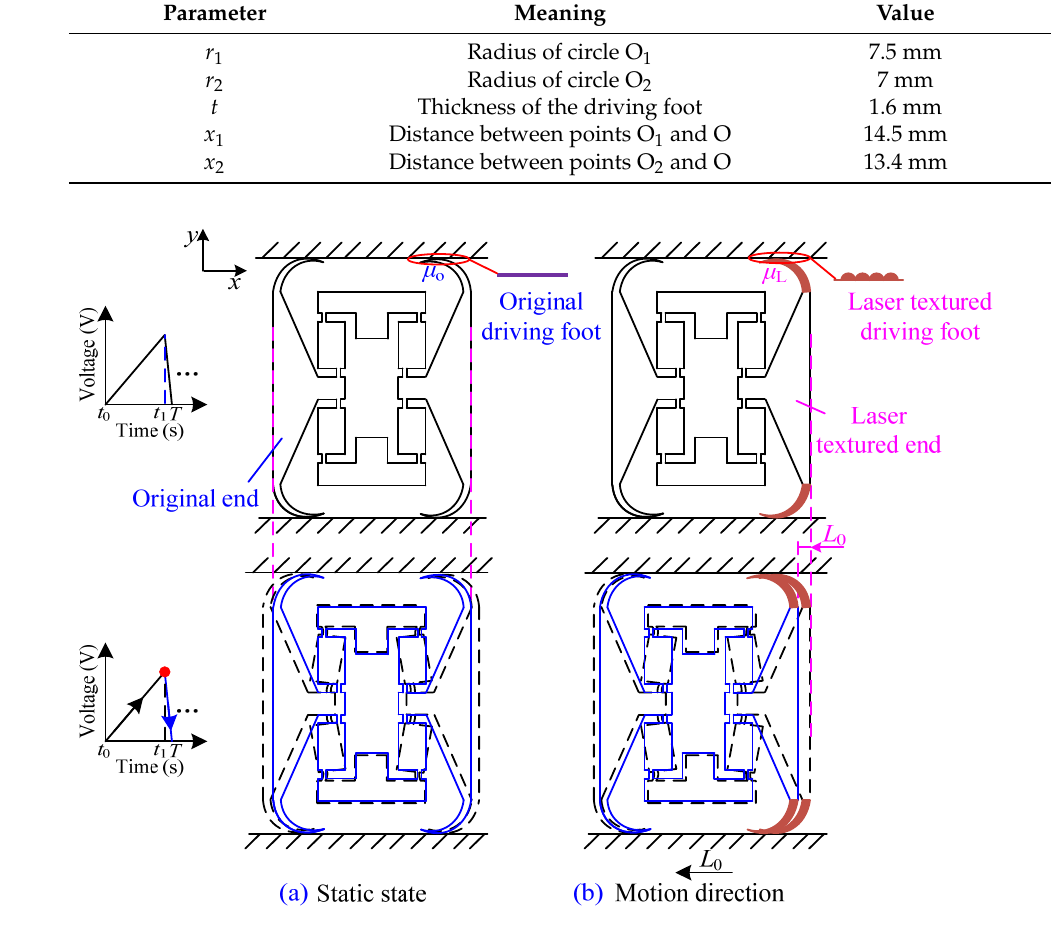
Figure 3. The motion process of the actuator with ( a ) the original driving feet and ( b ) the laser- textured driving feet.